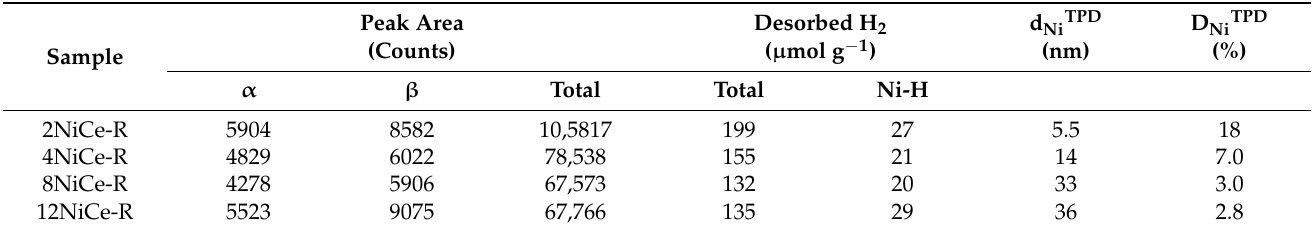
Table 3. Dispersion and average nickel particle size from the H 2 -temperature programmed desorption (H 2 -TPD) experiment after reduction at 800 ◦ C.